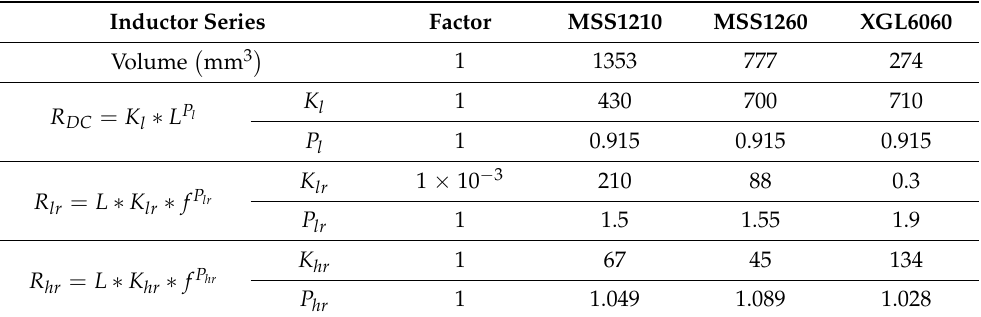
Figure 10. Evolution of the losses produced by three inductors under test. Validation of the R dc + R lr + R hr model. Table 2. Series resistance model parameters for the three manufacturer inductor series. Inductor